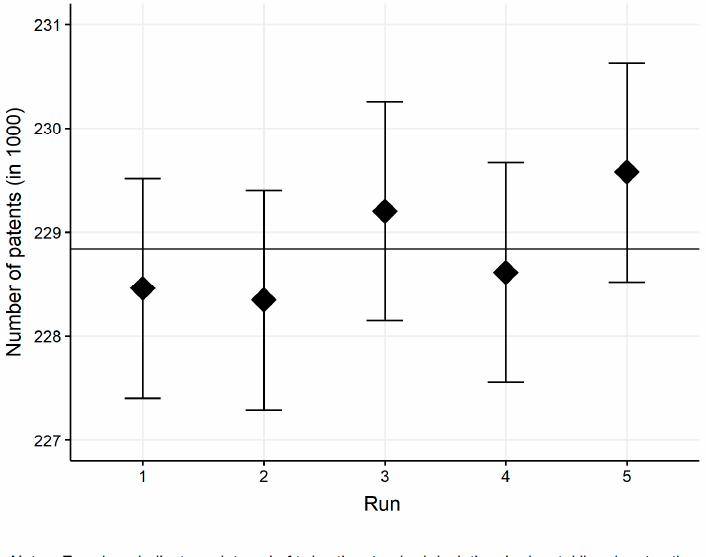
Figure A5. Distribution of patents over runs.